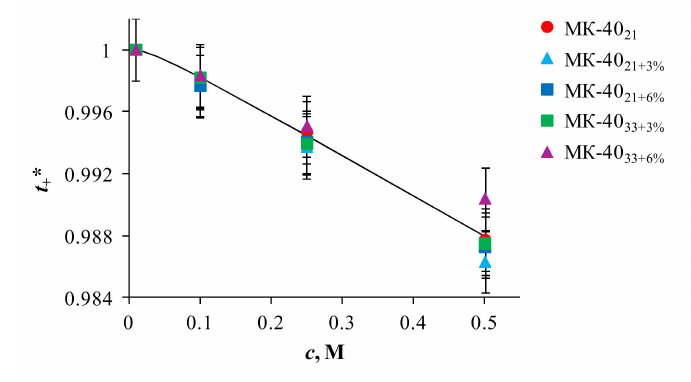
Figure 3. Concentrationdependencesoftheconterion(Na +